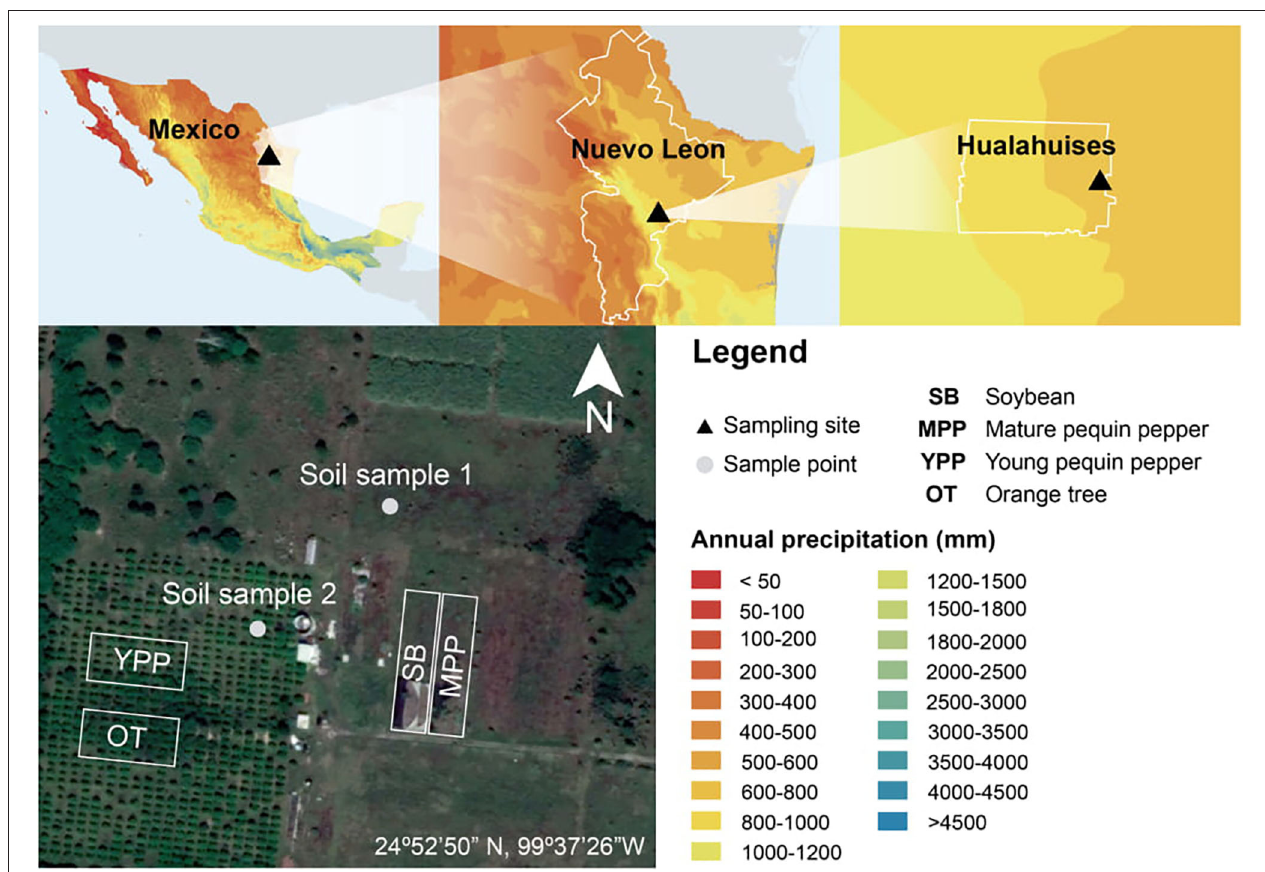
FIGURE 1 | Map of Tecnologico de Monterrey experimental field site in Hualahuises, Nuevo Leon, Mexico (24 ◦ 52.50’ N, 99 ◦ 37.26’ W). The sampling site was cataloged as semi-arid since it had < 500mm of annual precipitation (CONAGUA Gobierno de México, 2020).